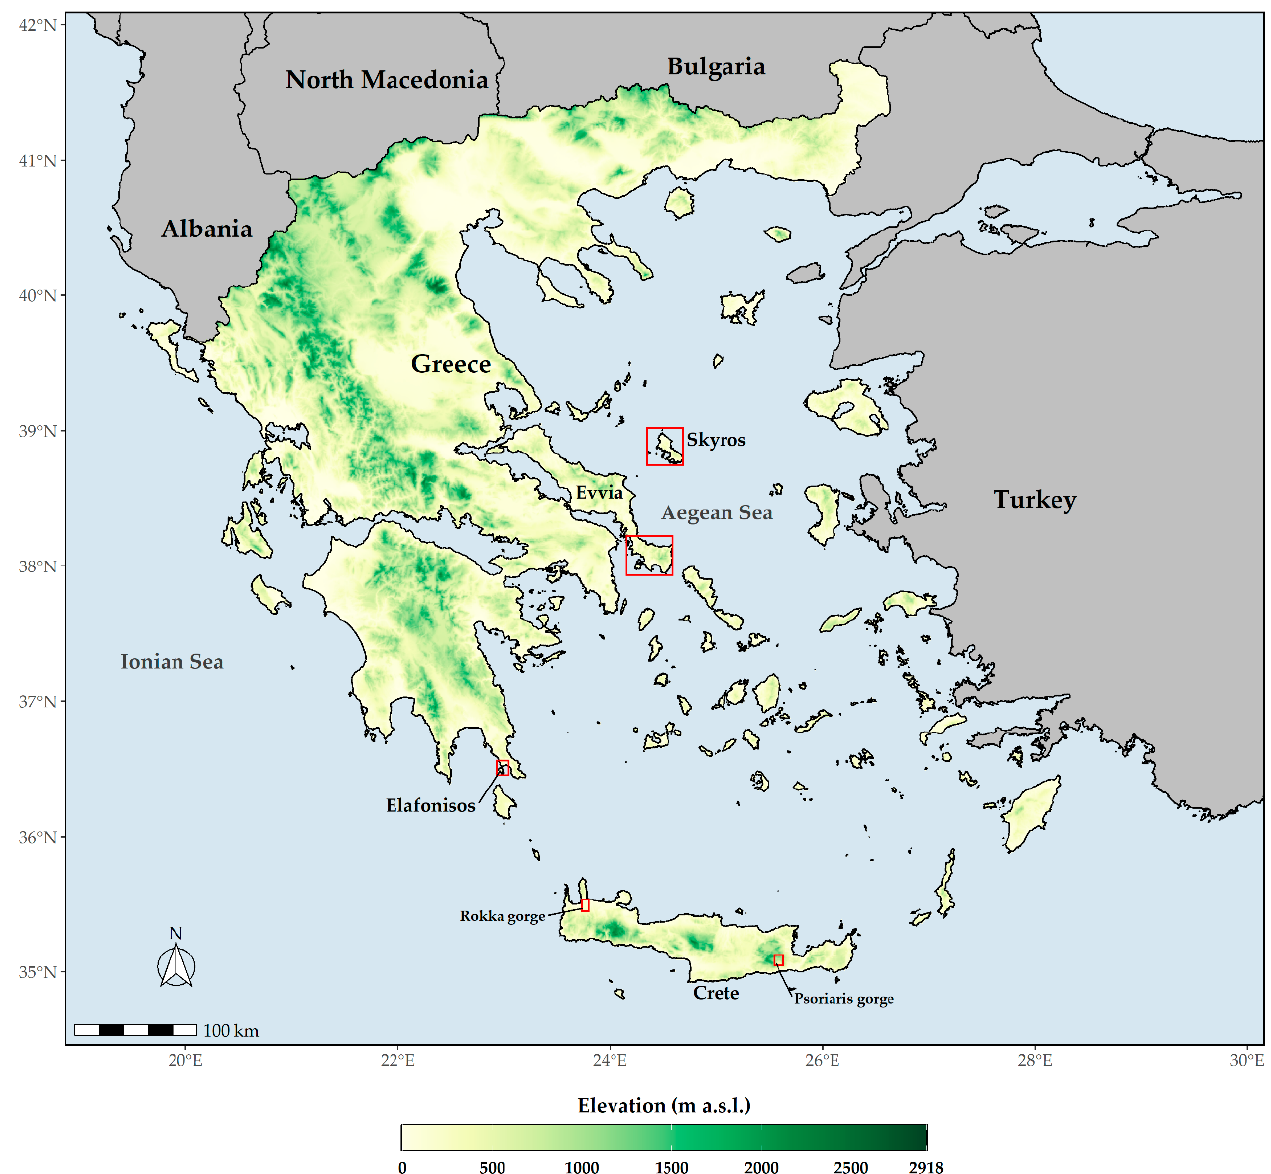
Figure 1. Map of Greece depicting the wider distributional area (red polygons) of the studied species. Aethionema retsina occurs in Skyros and Skyropoula, Allium iatrouinum in southern Evvia, Convolvulus argyrothamnos is a Cretan single endemic, and Saponaria jagelii is found on Elafonisos.